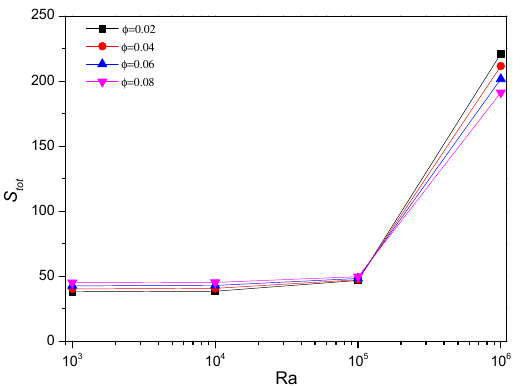
Figure 11. Total entropy as a function of Rayleigh number (Ra) at various values of solid volume fraction ( φ ). Ha = 0, Da = 0.01 and ε p = 0.4.